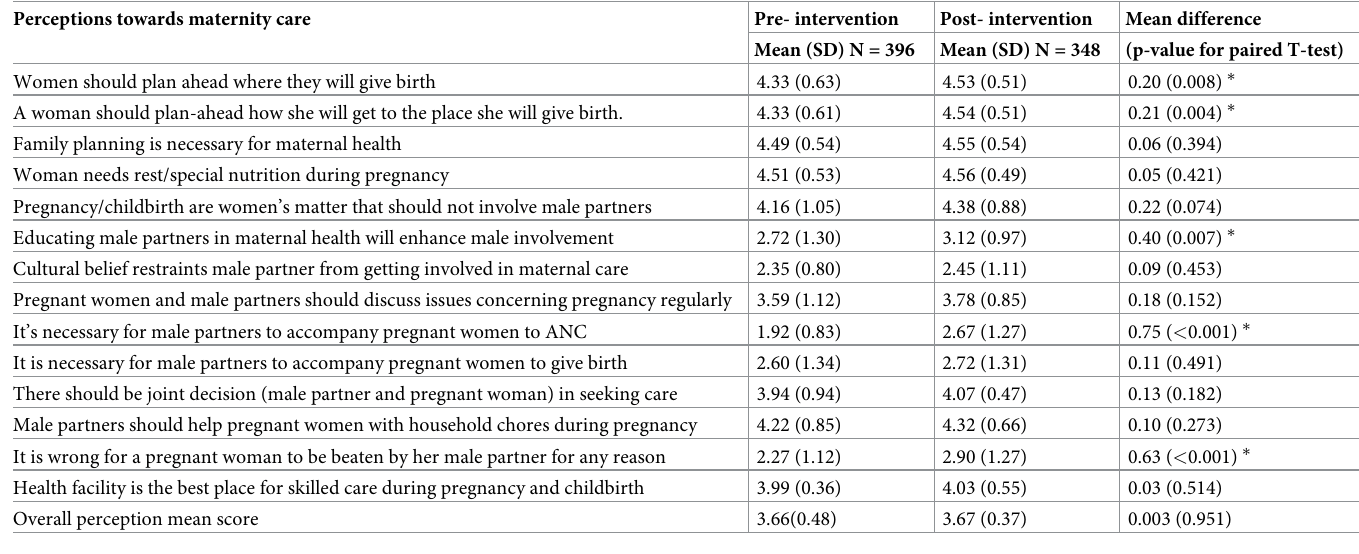
Table 3. Perception toward maternity care and safe motherhood among men in rural communities pre- and post-intervention. Perceptions towards maternity